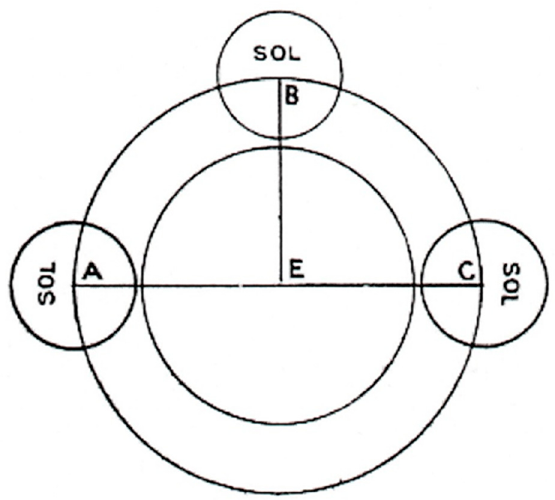
Figure 1. The Earth is a globe and the sun (SOL) is equidistant at all locations. (Reproduced from Williams [5]) .